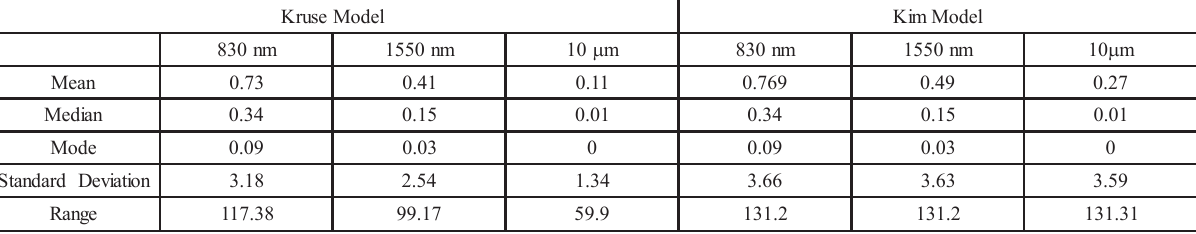
TABLE 4. DESCRIPTIVE STATISTICS OF ESTIMATED OPTICAL ATTENUATION FOR THE YEAR 2011